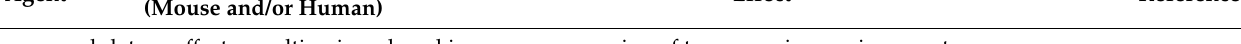
Table 1. Immune-modulatory effects of anti-VEGF TKIs and mAbs in RCC.